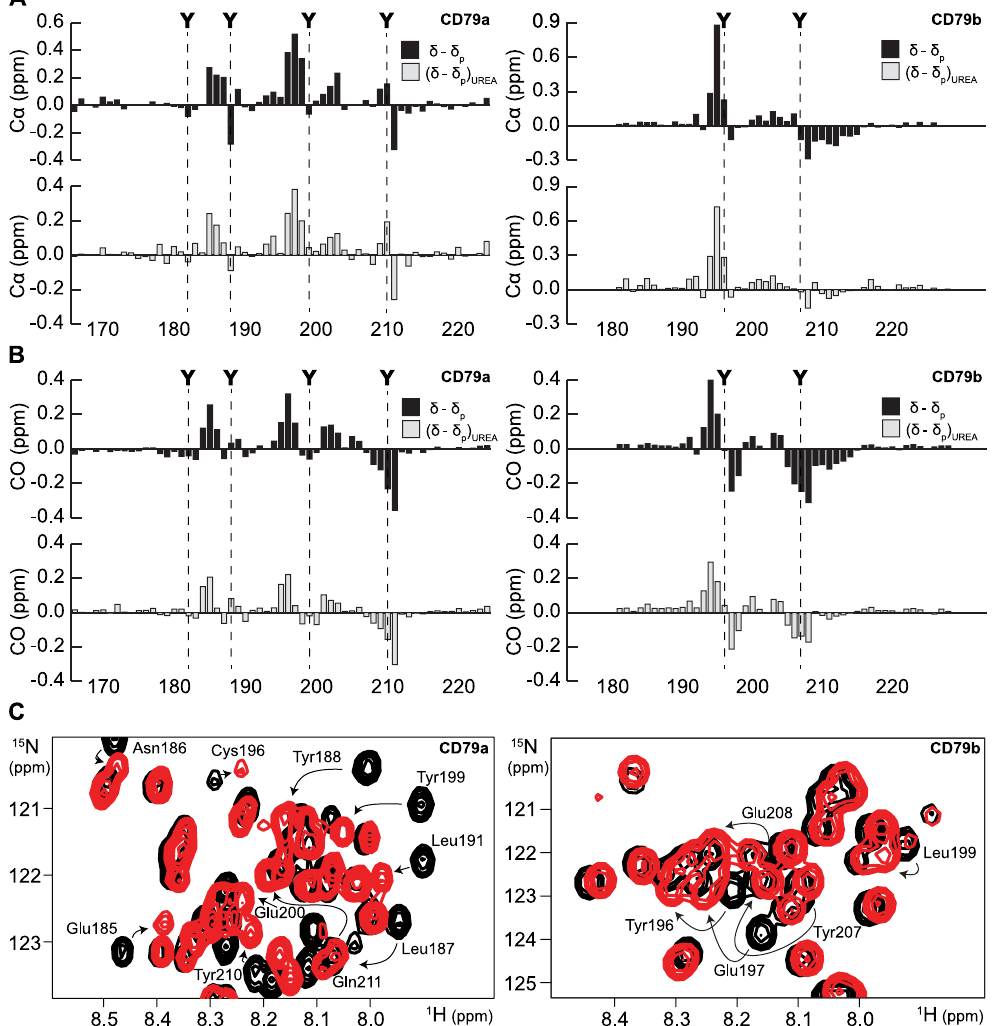
Figure 3. Chemical shift changes induced by tyrosine phosphorylation. ( A ) d 2 d P (black bars) and ( d 2 d P ) UREA (gray bars) of CD79a and CD79b calculated from C a chemical shifts. For CD79a, significant d 2 d P values can be observed surrounding Tyr188, Tyr199 and Tyr210 indicating phosphorylation of these sites. For CD79b, such values are observed surrounding Tyr196 and Tyr207. A comparison between d 2 d P and ( d 2 d P ) UREA reveals that a dominating part of the chemical shift changes induced by phosphorylation is still present in 6 M urea. ( B ) d 2 d P (black bars) and ( d 2 d P ) UREA (gray bars) of CD79a and CD79b calculated from CO chemical shifts. Analysis using CO chemical shifts results in similar patterns as C a . ( C ) Overlays of 1 H- 15 N-HSQC spectra of CD79a P and CD79b P (red) and the corresponding spectra of CD79a and CD79b (black). Phosphorylation induces changes in the amide chemical shifts of targeted tyrosines as well as surrounding residues. Phosphorylated tyrosines show a 1 H downfield shift while the direction of the 15 N shifts varies. Upon phosphorylation, the amide peaks of the tyrosines tend to move into already crowded areas of the